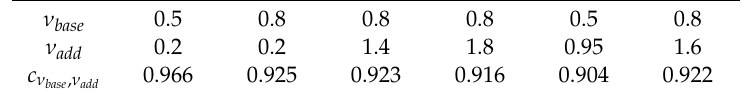
between the basic frequency ν base and the doubled frequency ν add ν base , add